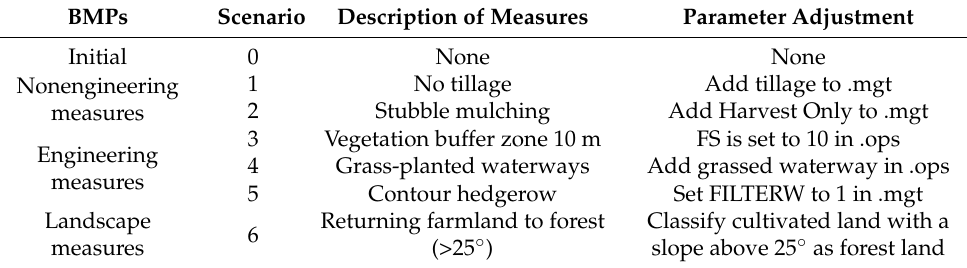
Table 3. Scenario settings of best management